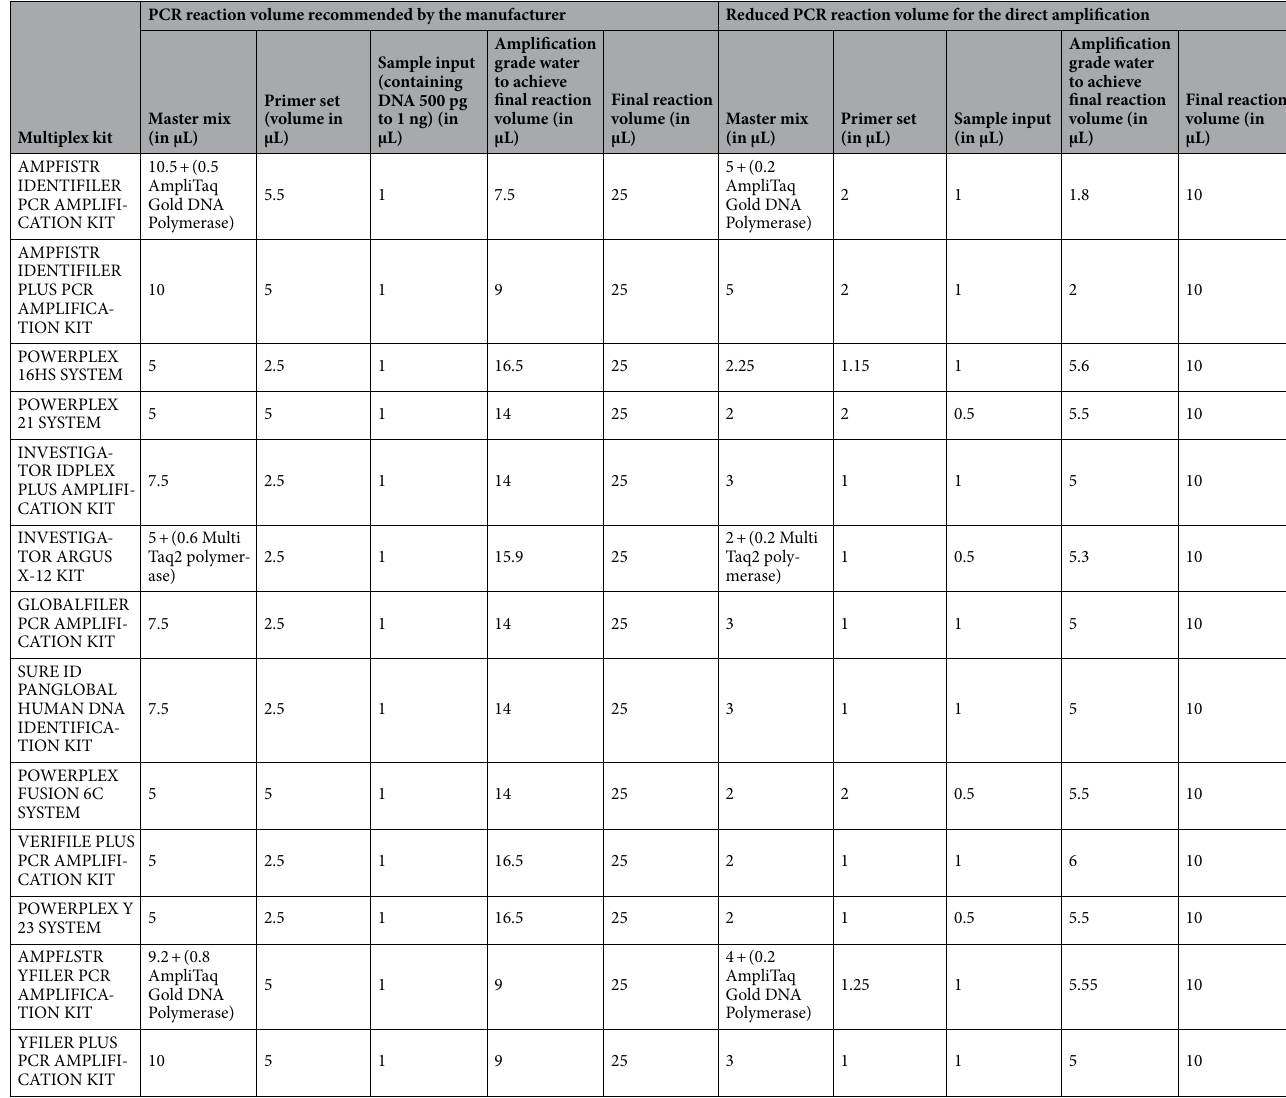
Table 4. Details of recommended and reduced PCR reaction